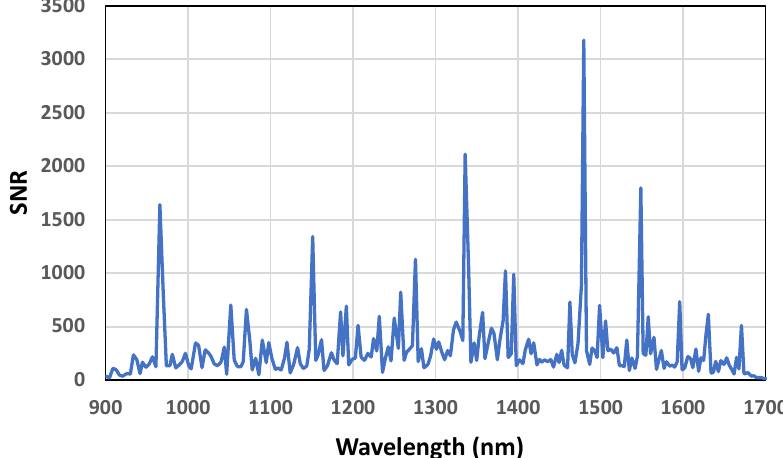
Figure 10. SNR of the Column scan as a function of wavelength.